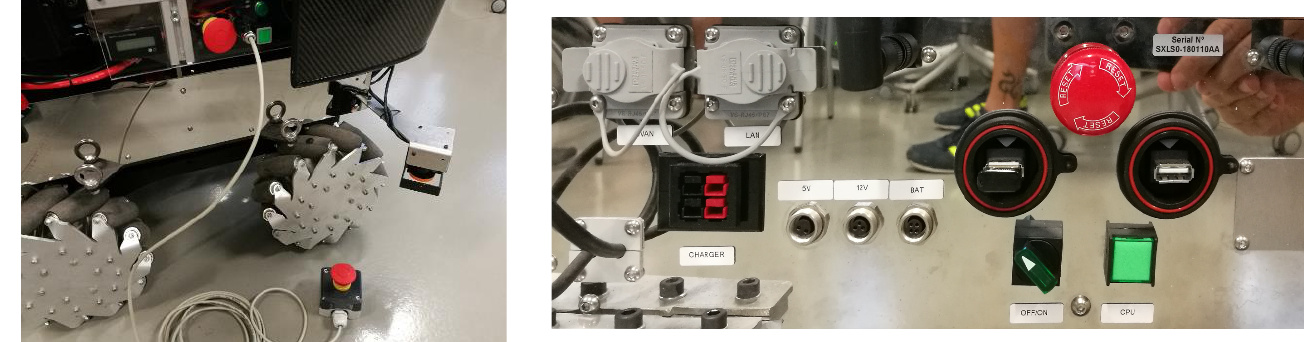
Figure 3. Safety buttons: ( left ) two safety buttons on the left side of the robotized wheelchair for the main CPU; ( right ) one safety button on the back of the wheelchair for the mobile